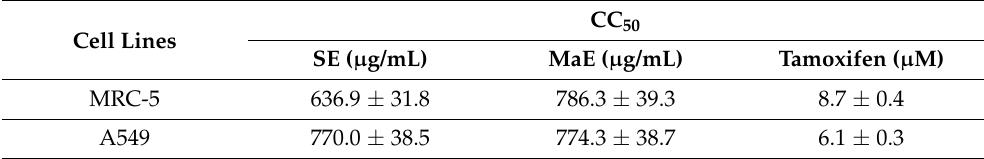
Table 2. In vitro cytotoxicity of P. americana seed